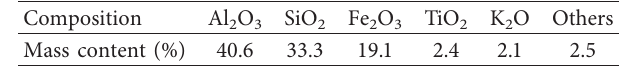
Table 1: Major components of laterite.